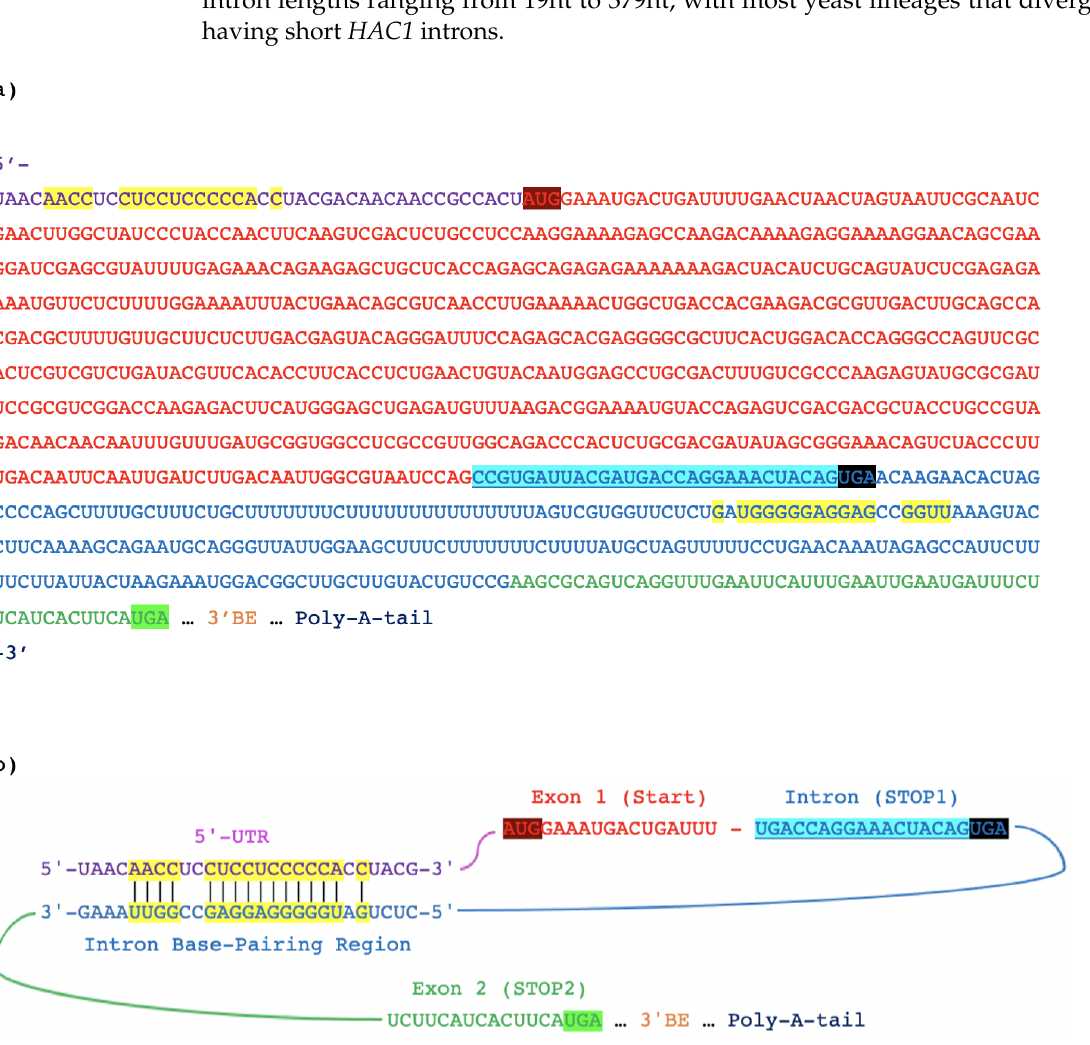
Figure 1. The HAC1 gene in S. cerevisiae . ( a ) The annotated HAC1 u mRNA illustrating its sequence elements: 5′ untranslated region (5′ UTR) in purple, first exon in red, the intron in blue, and the second exon in green. The start codon (START) is highlighted in dark red, and the in-frame stop codons in the intron (STOP1) and in the second exon (STOP2) are respectively highlighted in black and green. Nucleotides involved in the long-ranged base-pair interactions between the 5′ UTR and intron are highlighted in yellow, while the intronic sequence proposed to encode a C-terminal degron in Hac1 u p is shaded in blue. ( b ) An illustration showing the base-pairs formed between the 5′ UTR and intron in HAC1 u to inhibit translation initiation of the pre-mRNA, with the same color scheme as in ( a ).